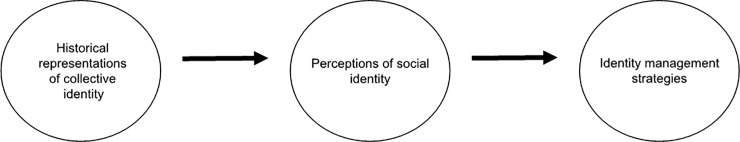
The hypothesised relationship between historical representations of collective identity, perceptions of social identity, and identity management strategies.